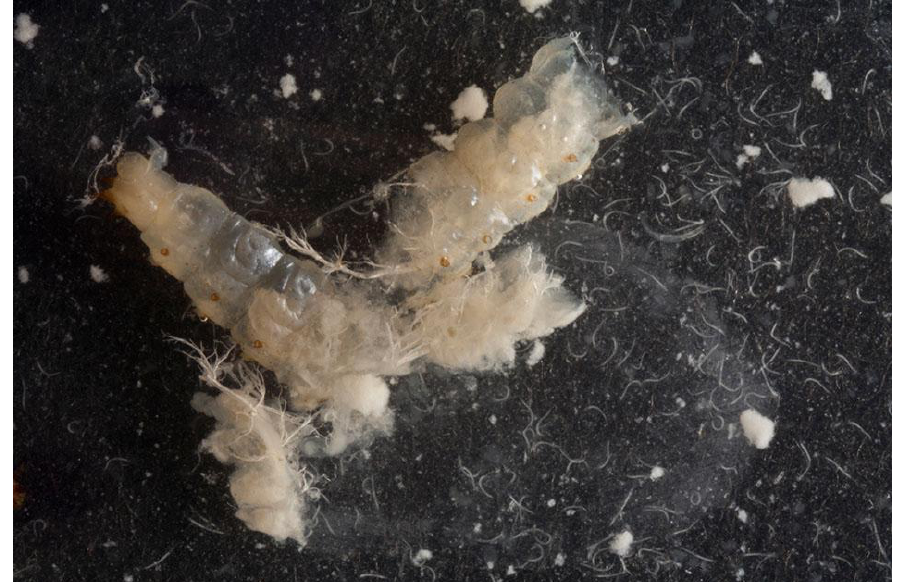
Figure 2. Dissected Aethina tumida larvae releasing the entomopathogenic nematode Steinernema carpocapsae